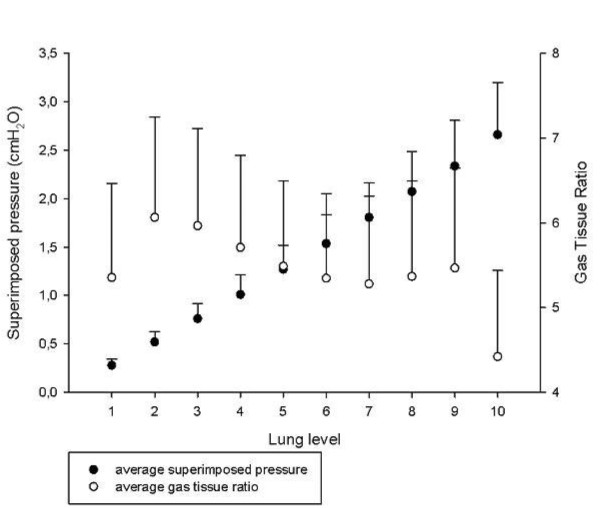
Superimposed pressure and gas/tissue ratio as a function of the sterno-vertebral level. Average superimposed pressure (filled circles) and the average gas/tissue ratio (empty circles) as a function of the sterno-vertebral level.